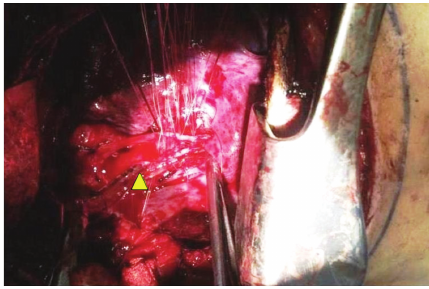
Figure 4: Tracheal repair with sutures along its length while the cross field endobronchial tube is in